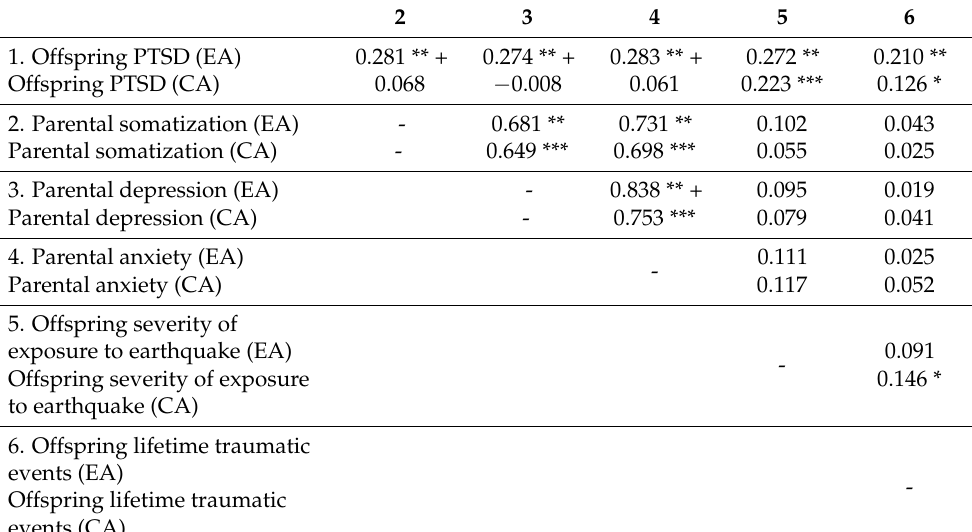
Table 2. Correlations among the study variables in the EA and CA.